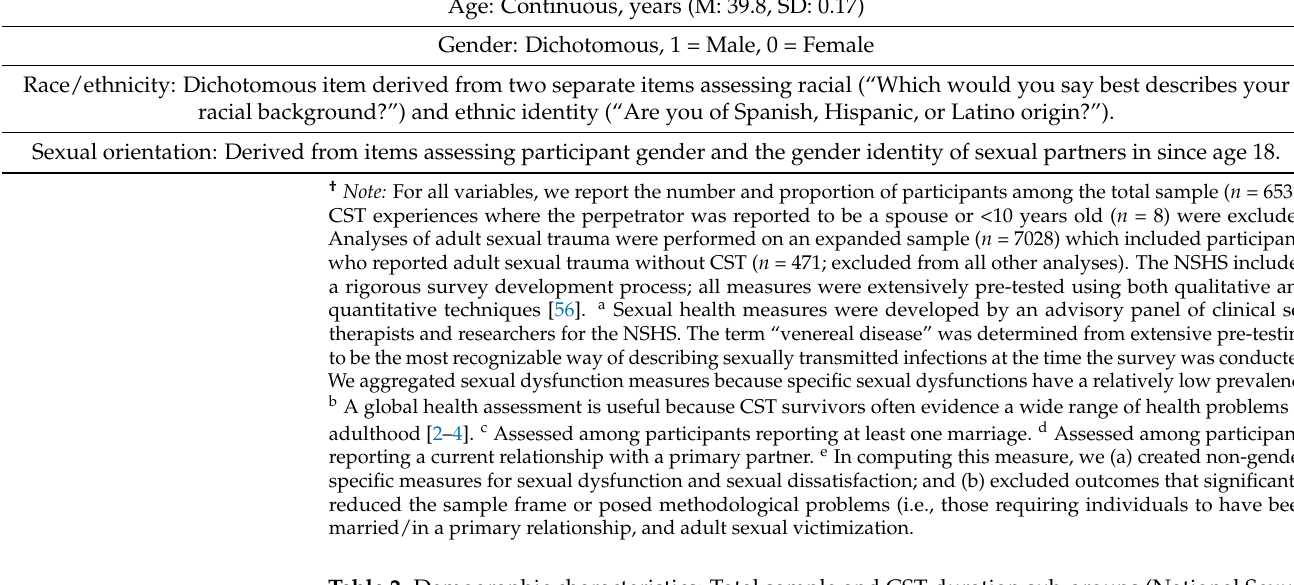
Table 2. Demographic characteristics: Total sample and CST duration sub-groups (National Sexual Health Survey, 1996) †